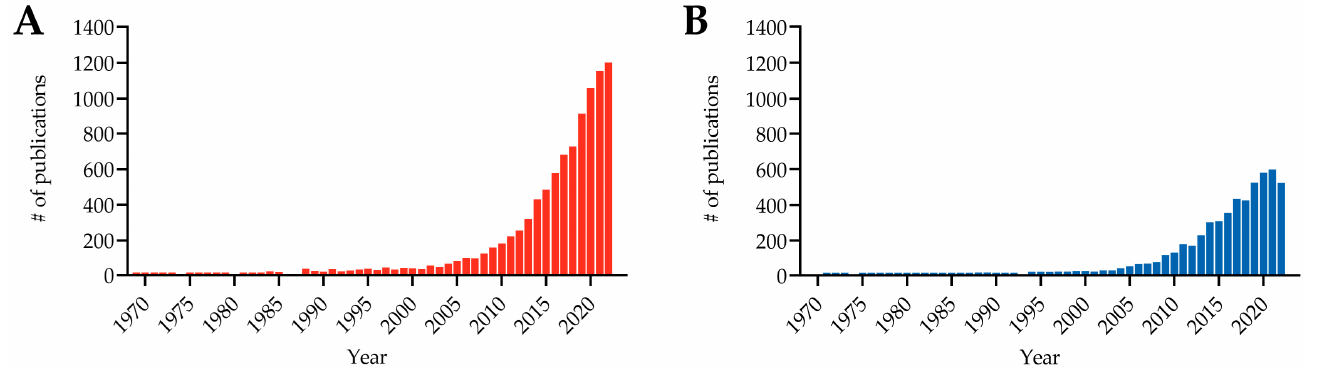
Figure 3. Periprosthetic joint infection (PJI)-related publication counts between 1969 and 2022. ( A ) All PJI-related publications were calculated based on a PubMed query with keywords “PJI”, “prosthetic joint infection”, or “periprosthetic joint infection”. ( B ) PJI diagnosis-related publications were calculated based on a PubMed query with keywords “PJI diagnosis”, “prosthetic joint infection diagnosis”, or “periprosthetic joint infection diagnosis”. Query conducted on 16 January 2023. Graph created in GraphPad Prism v9.4.0 (CA, USA).